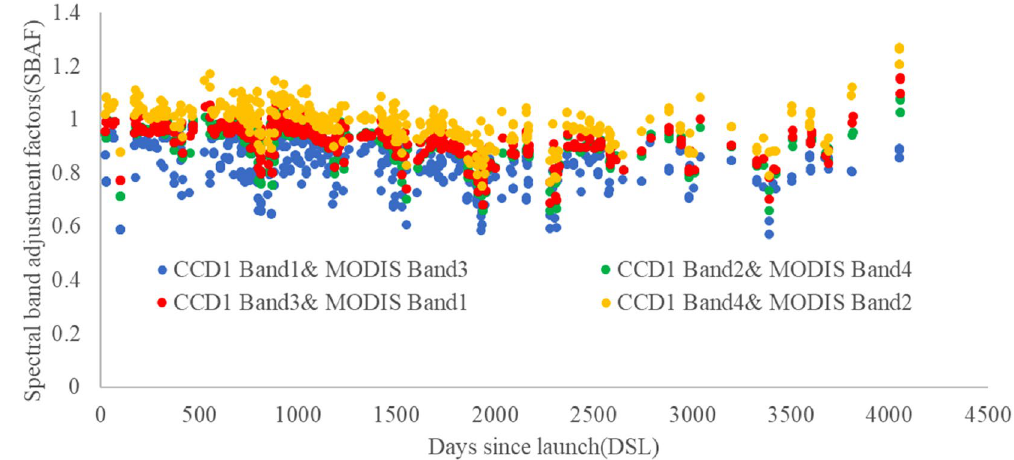
Figure 7. The spectral band adjustment factor of the